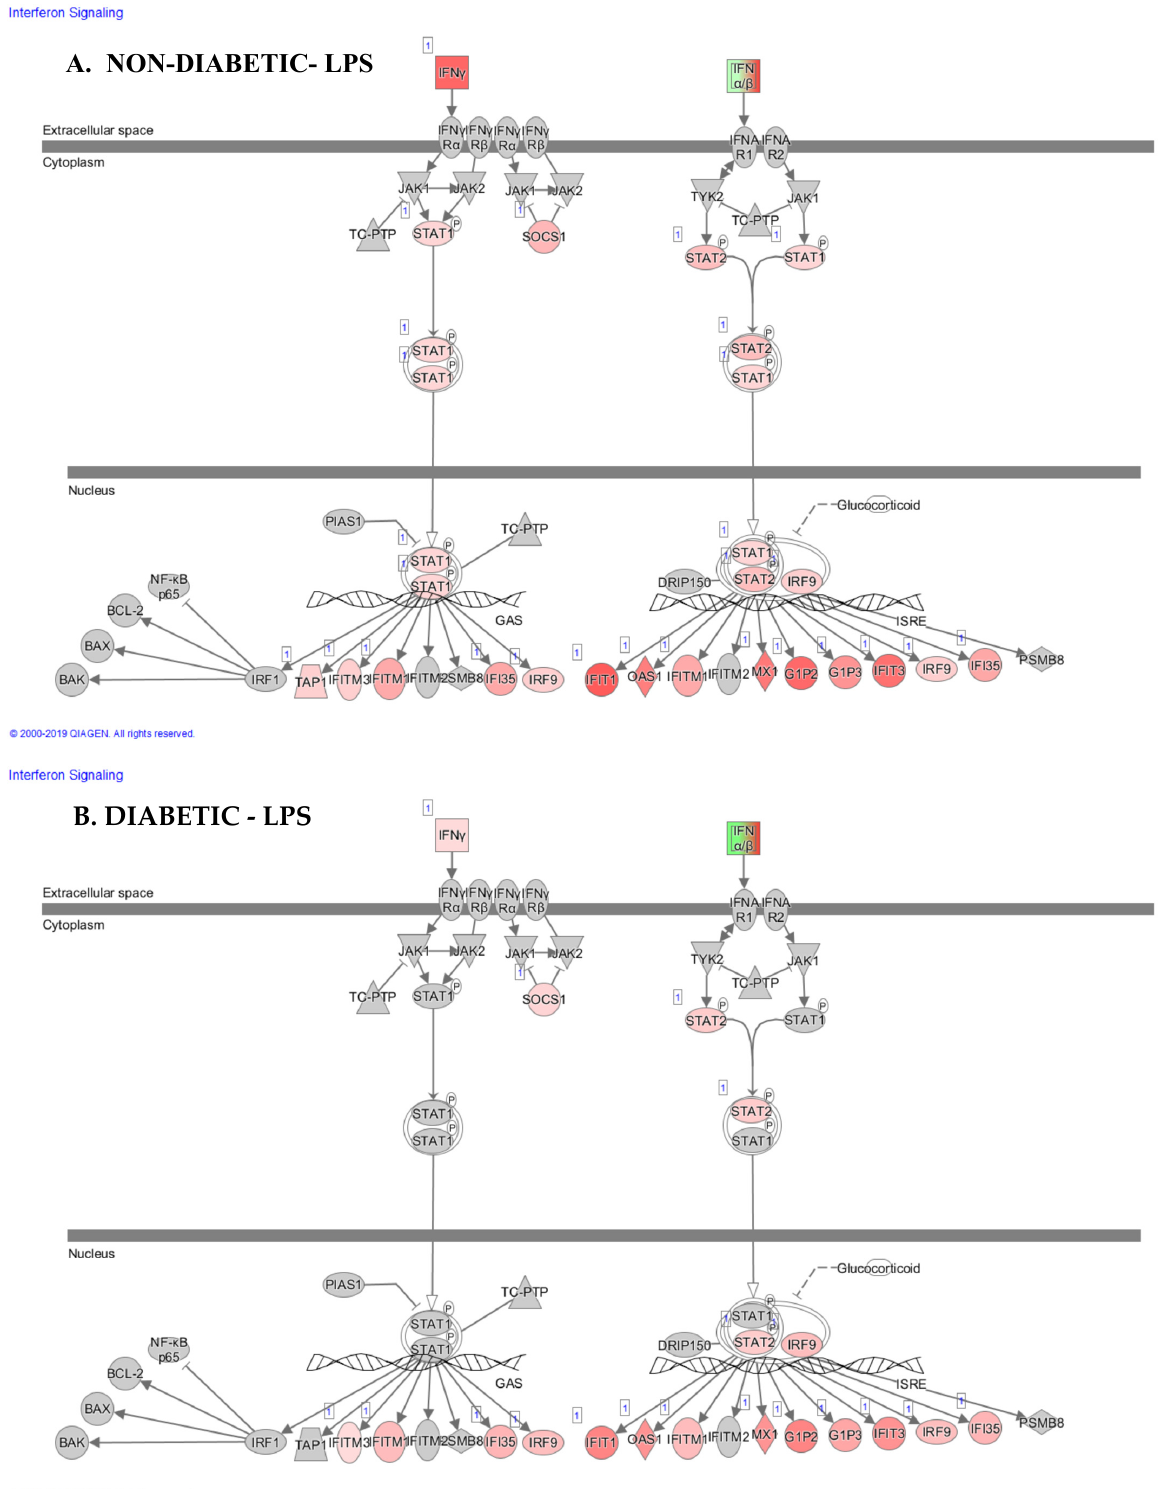
Figure 9. The interferon signaling pathway in human PBMC. The interferon signaling pathway plays a critical role in the induction of immune response by LPS or viruses: the STAT1 and STAT2 transcription factors play a major role in the transcription of interferon-activated genes. ( A ). LPS-non- diabetic and ( B ). LPS-diabetic. Red color denotes activation of genes, green color denotes repression of genes, and grey color denotes no change in gene